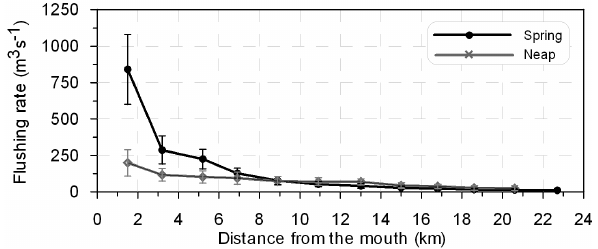
Fig. 7. Spatial variation of the mean flushing rate (m 3 s − 1 ) during spring and neap